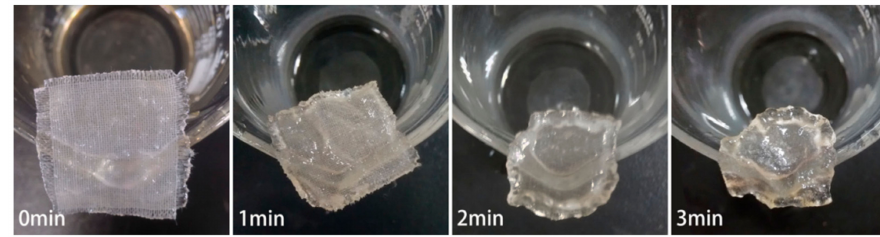
Figure 2. Swelling of CF in IL with time varying.